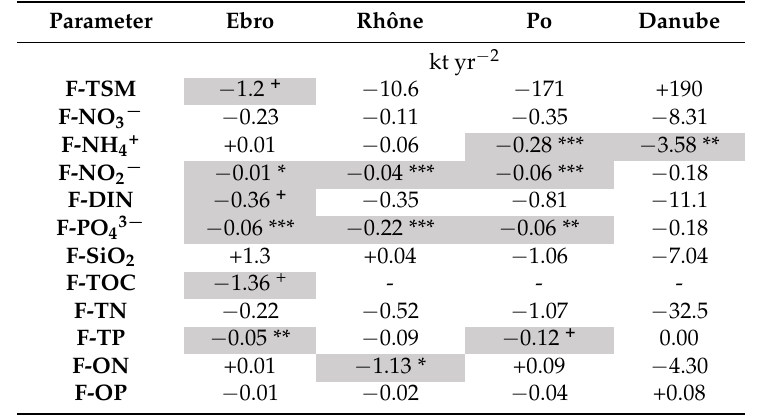
Figure A2. Box Whisker Plot (median and quartiles) of monthly distribution of nutrient concentration ( μ mol L − 1 ) in the Ebro, Rhône, Po and Danube waters, in 1990–2012. Table A4. Slope (kt yr − 2 ) of annual river transport (F; kt yr − 1 ) of TSM, nutrients and organic matter vs time (yr) estimated by MKT and ST since the 1980s for Ebro, Rh ô ne and Po and since 1997 for the Danube. The levels of significance (Mann-Kendall test) of these trends are highlighted in gray (*** α = 0.001, ** α = 0.01, * α = 0.05, + α = 0.1, no symbols α >